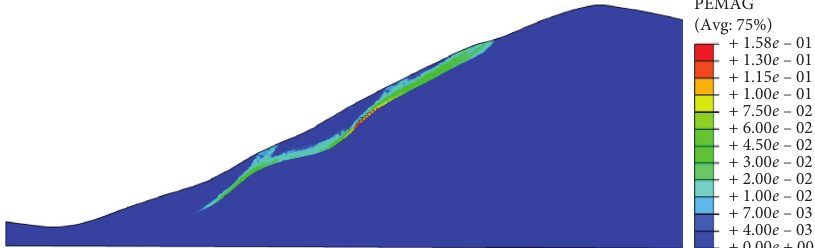
Figure 8: Plastic strain cloud map of the slope at the critical strength at t � 0.624s.